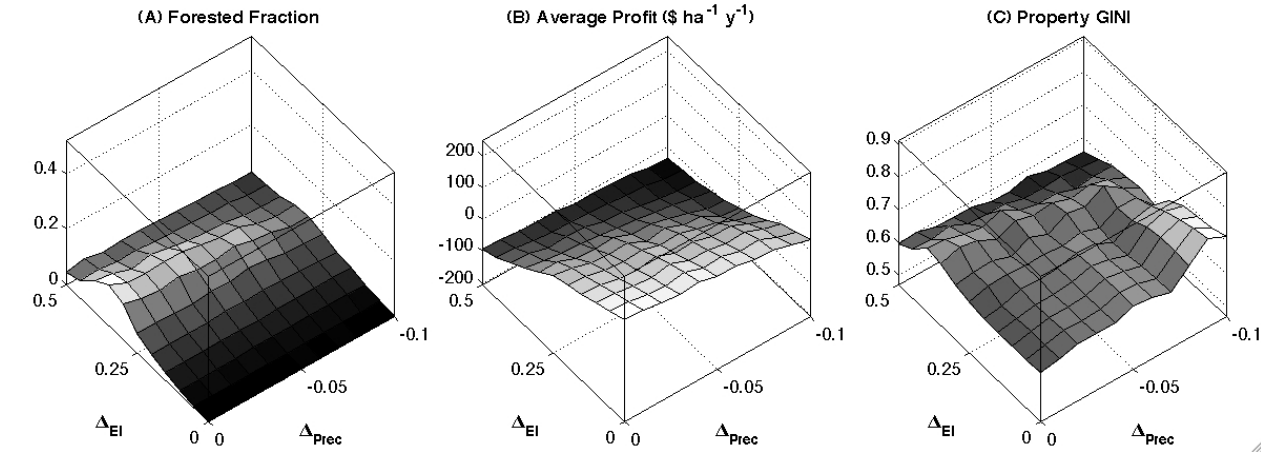
Fig. 4. Response surfaces for Policy Scenario 1 (tiered environmental licensing), Rancher Scenario 1 (low networking, low size effect) showing sensitivity to change in expected income D EI and in precipitation D Prec. (A) Average forested fraction across the landscape; (B) Average profit per hectare of property per year; (C) Level of land aggregation measured by the property GINI coefficient. Response surfaces for Rancher Scenarios 1-4 are shown in Appendix 5, as are surfaces for the standard deviations across